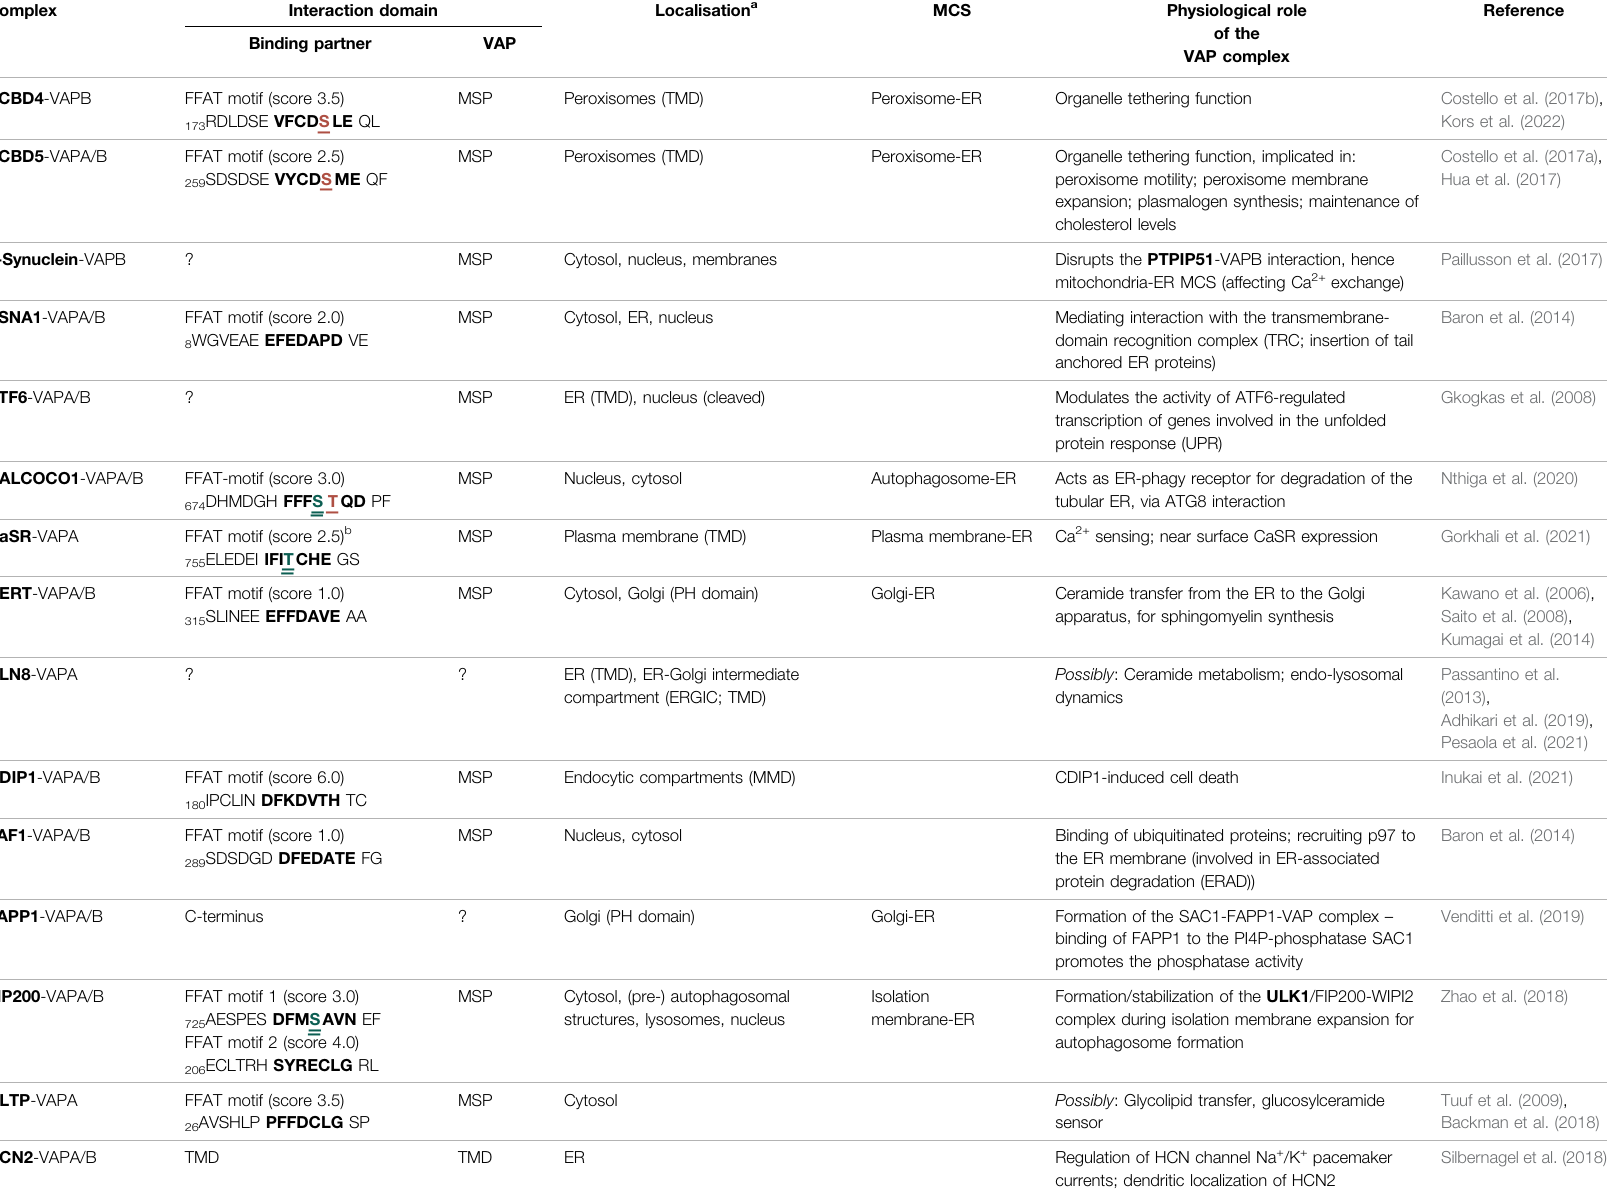
TABLE 1 | An overview of experimentally con fi rmed VAP binding partners in mammalian